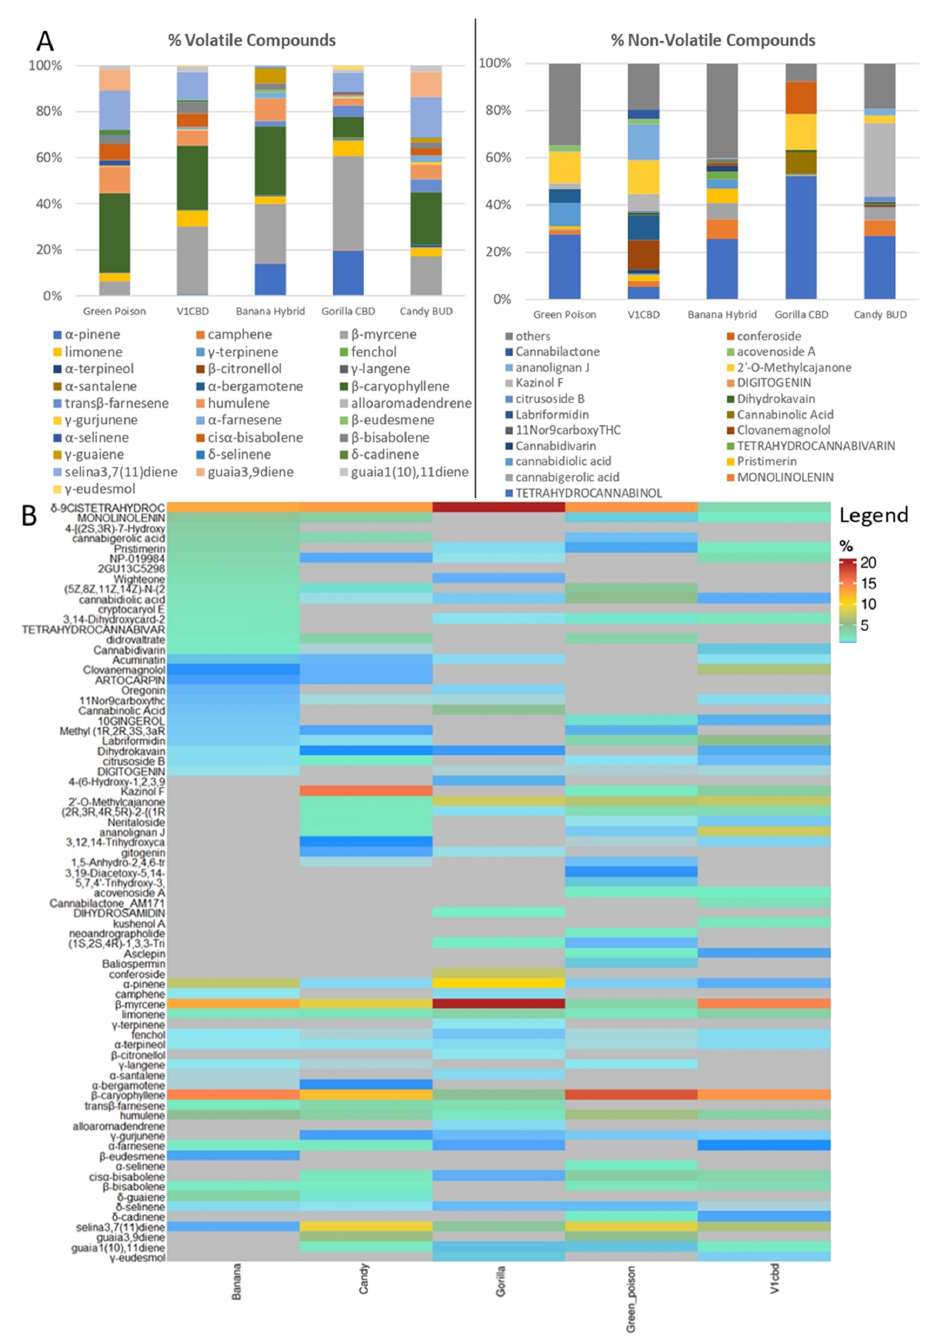
Figure 2. ( A ). Bar plot of the chemical composition (percentage mean value) of C. sativa inflorescences for volatile and non-volatile compounds. ( B ). Heatmap of normalized by sum metabolites percentage in five cultivars of C. sativa L. Each cultivar is indicated in the column, every row indicates a compound. Red indicates high abundance, whereas compounds under the detection threshold are in